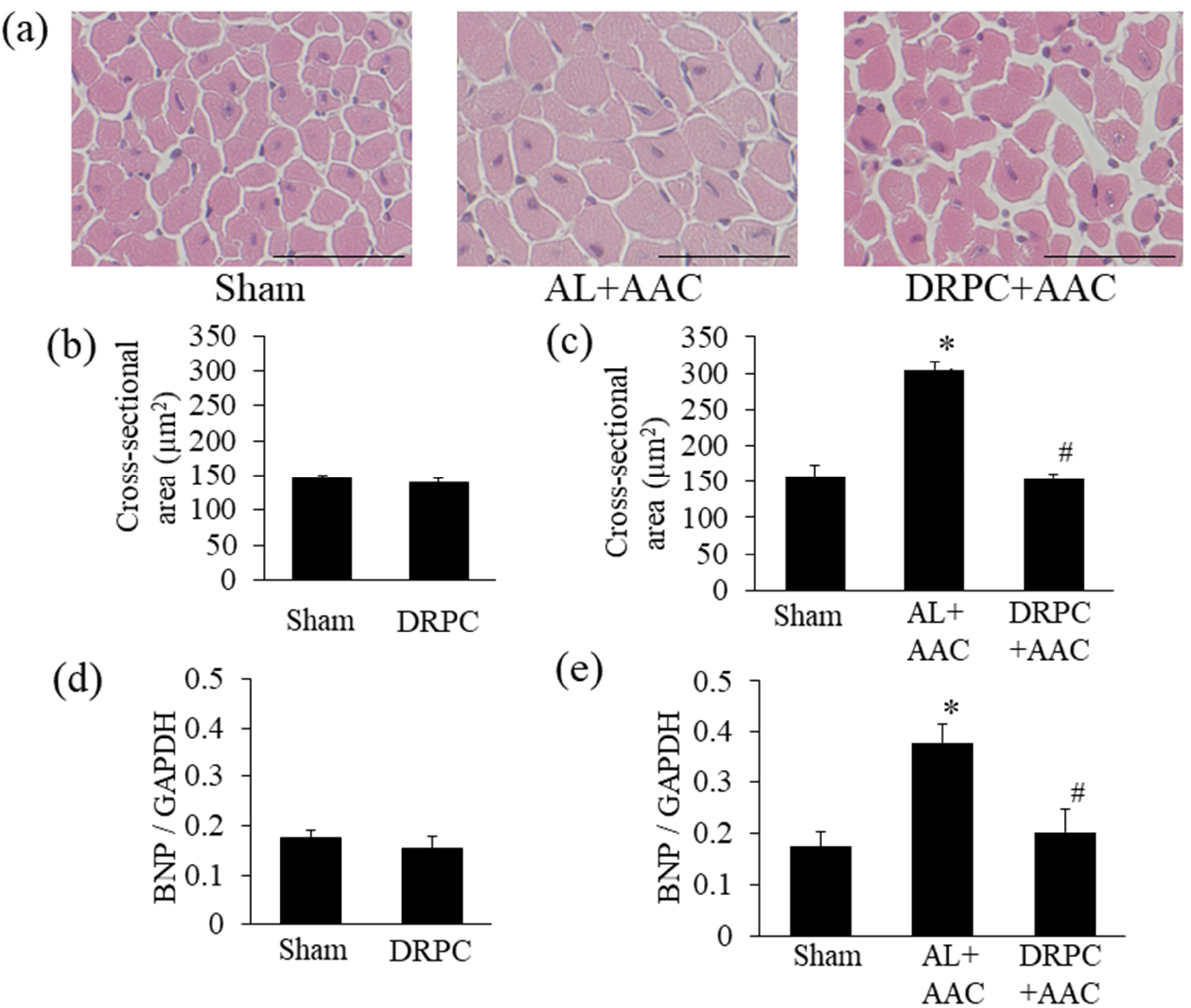
Figure 3. Effects of dietary restriction preconditioning on pressure overload-induced myocyte hypertrophy and BNP mRNA expression. ( a ) Representative photomicrographs of hematoxylin & eosin-stained transverse left ventricular cross-sections 2 weeks after surgery. Bars indicate 50 µ m. Cardiac myocyte cross-sectional areas in the left ventricle before ( b ) and 2 weeks after surgery ( c ) (before surgery, Sham: n = 5, DRPC: n = 7, after surgery, Sham: n = 5, AL+AAC: n = 7, DRPC+AAC: n = 7). BNP mRNA expression in the left ventricle before ( d ) and 2 weeks after surgery ( e ) (before surgery, Sham: n = 6, DRPC: n = 5, after surgery, Sham: n = 6, AL+AAC: n = 6, DRPC+AAC: n = 5). * p < 0.05 versus Sham. # p < 0.05 versus AL+AAC.